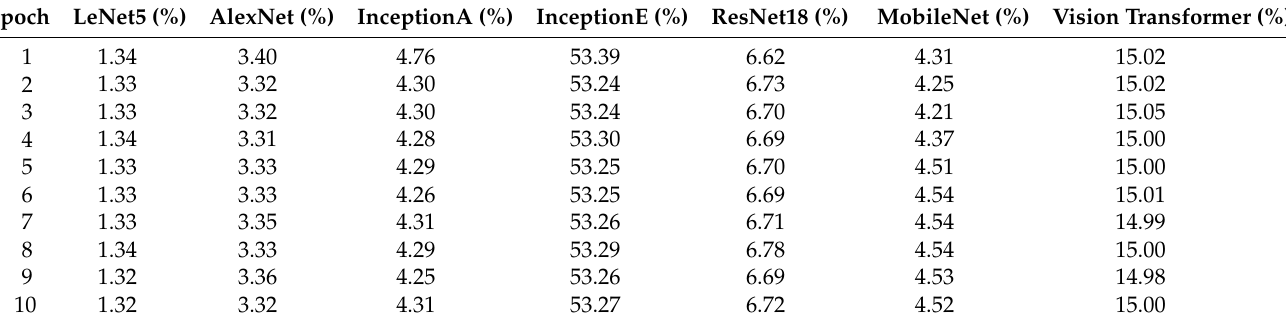
Table 6. Operation timetable for each epoch of each